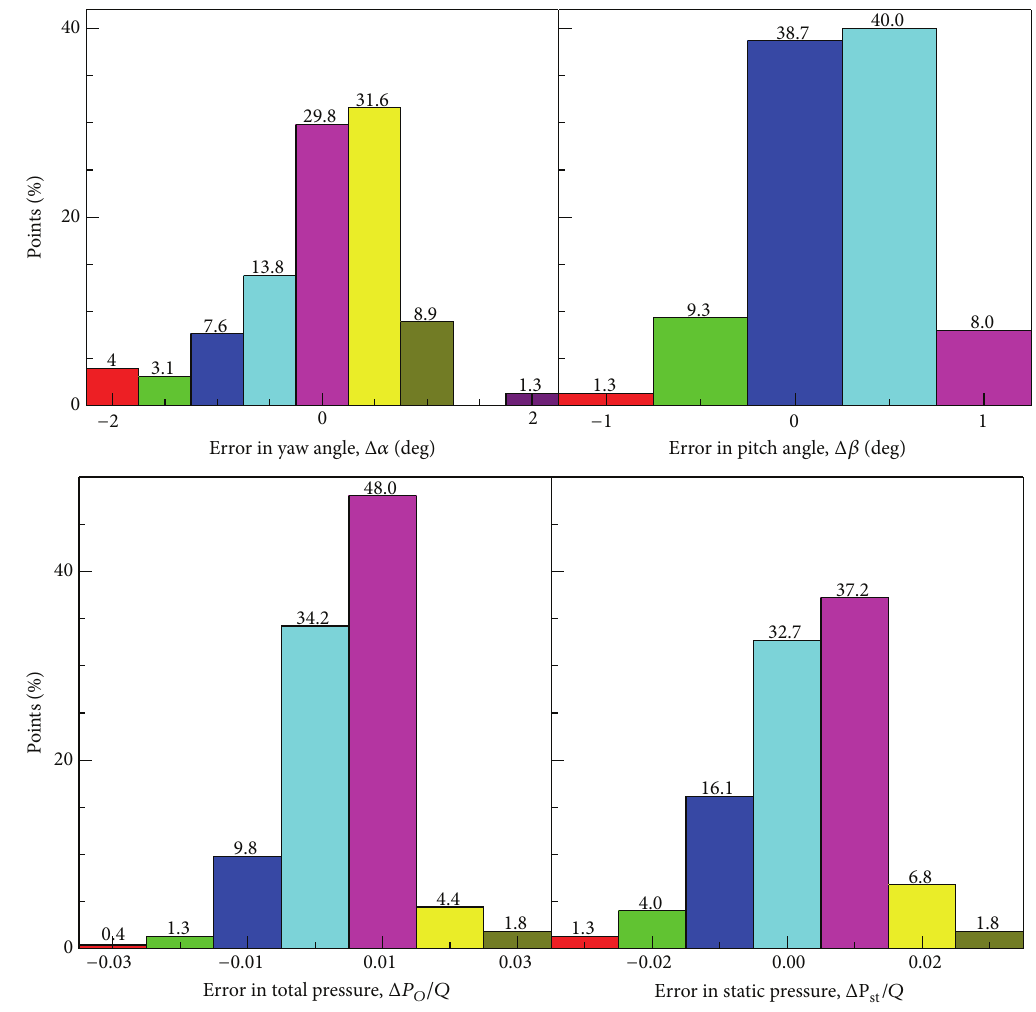
Figure 7: Histograms of interpolated errors in